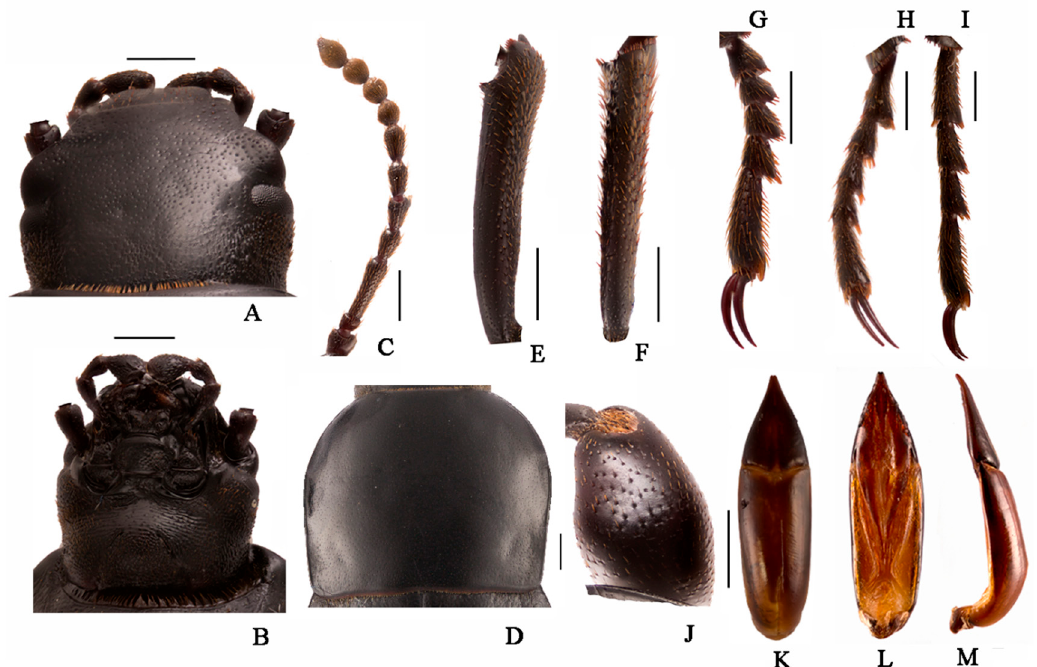
Figure 7. Nalepa polita Li & Ren sp. n. ( A ) head, dorsal view; ( B ) head, ventral view; ( C ) antenna; ( D ) pronotum; ( E ) protibia; ( F ) mesotibia; ( G ) protarsus; ( H ) mesotarsus; ( I ) metatarsus; ( J ) profemora; ( K – M ) aedeagus: ( K ) dorsal view; ( L ) ventral view; ( M ) lateral view. Scale bars: ( A – J ) (1.0 mm), ( K – M ) (1.0 mm); from Gyawa, Garzê, Sichuan, China.